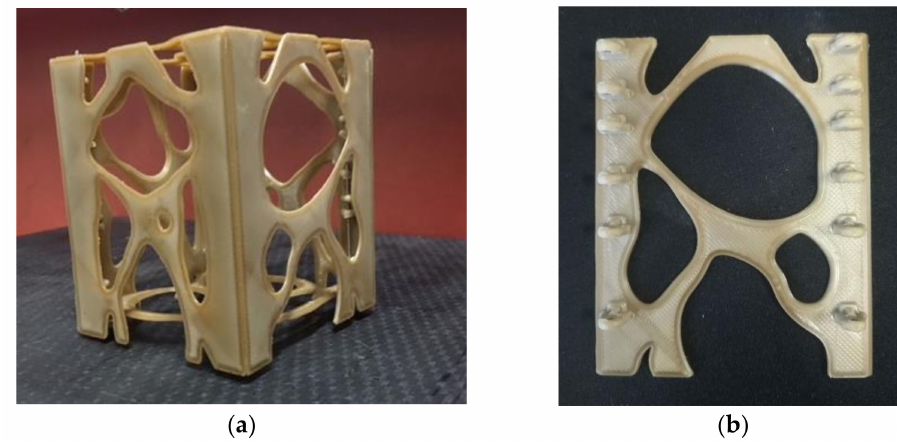
Figure 10. 3D-printed PEEK optimized nanosat. ( a ) view of the entire 3D printed Nanosat ( b ) detail of one 3D printed side